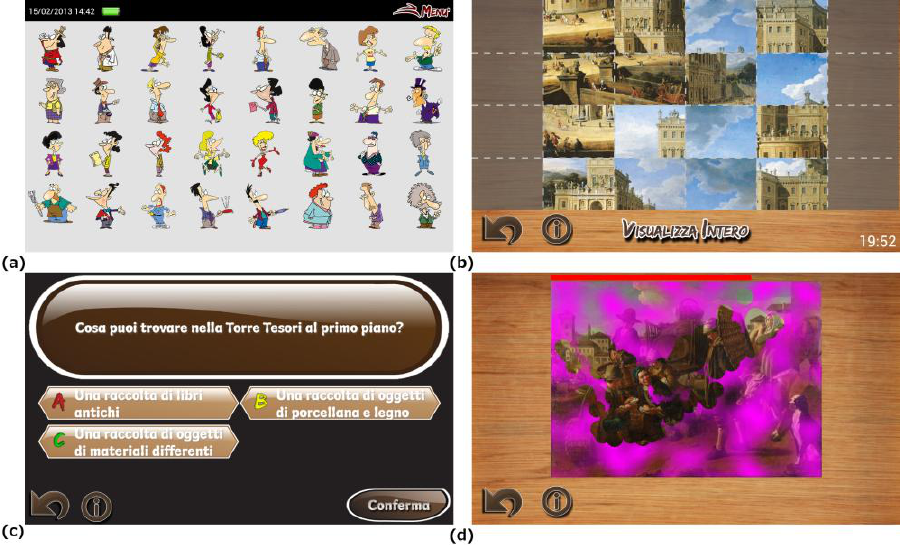
Figure 8. Intrigue at the museum : the list of suspects ( a ); examples of observation ( b ); reasoning ( c ) and arcade ( d )